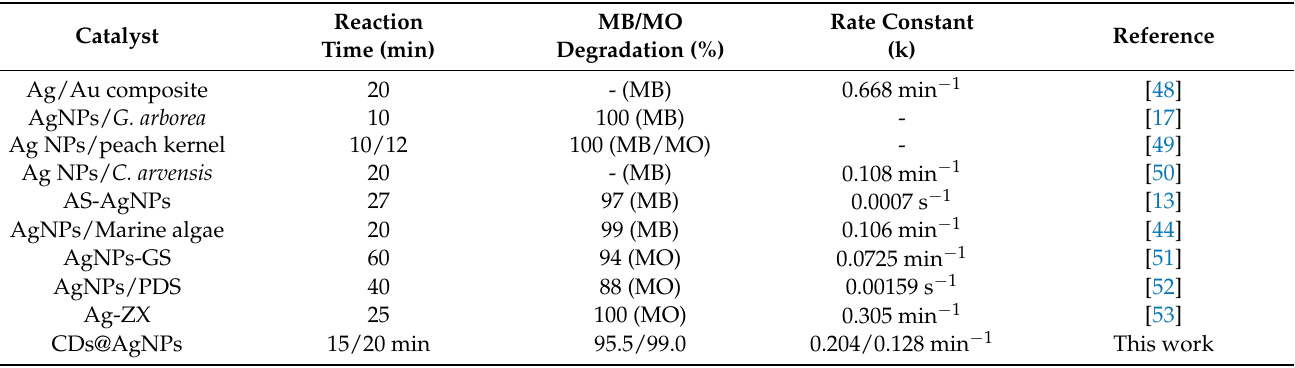
Figure 6. Photographic images of the MB and MO aqueous solutions with the CDs@AgNP composite in the presence of NaBH 4 at different reaction (degradation) times under ambient conditions. Table 1. Comparison of the catalytic performances of AgNP-based composites from